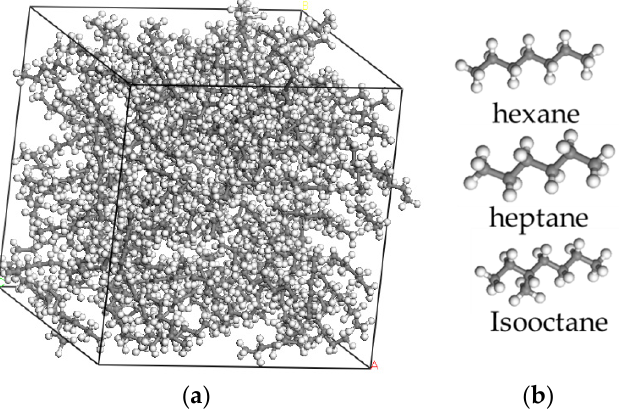
Figure 1. Molecular configuration of oil droplet composition (grey—carbon, white—hydrogen): ( a ) oil phase box; ( b ) oil phase composition. Table 1. The binding energy of different modifiers to graphene oxide.